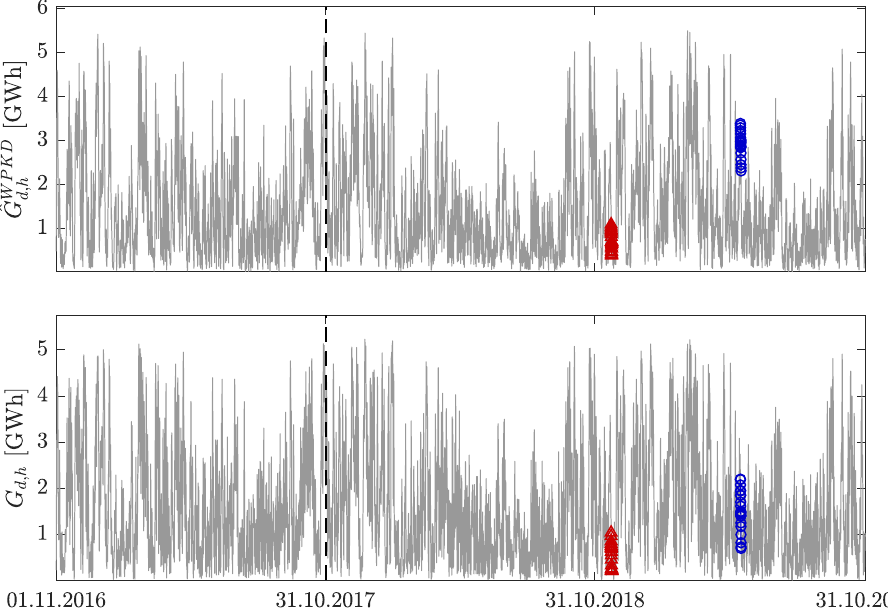
Figure 2. Two-days-ahead wind generation Initial Daily Coordination Plan (WPKD) forecasts (top) and actual wind generation (bottom) in Poland from the period 1 November 2016–30 September 2019. The dashed line marks the beginning (1 November 2017) of the two-year evaluation period. The red triangles (24 h of 22 November 2018) and blue circles (24 h of 16 May 2019) correspond to the two largest draw-downs in profitability, see Section 5.2 and Figure